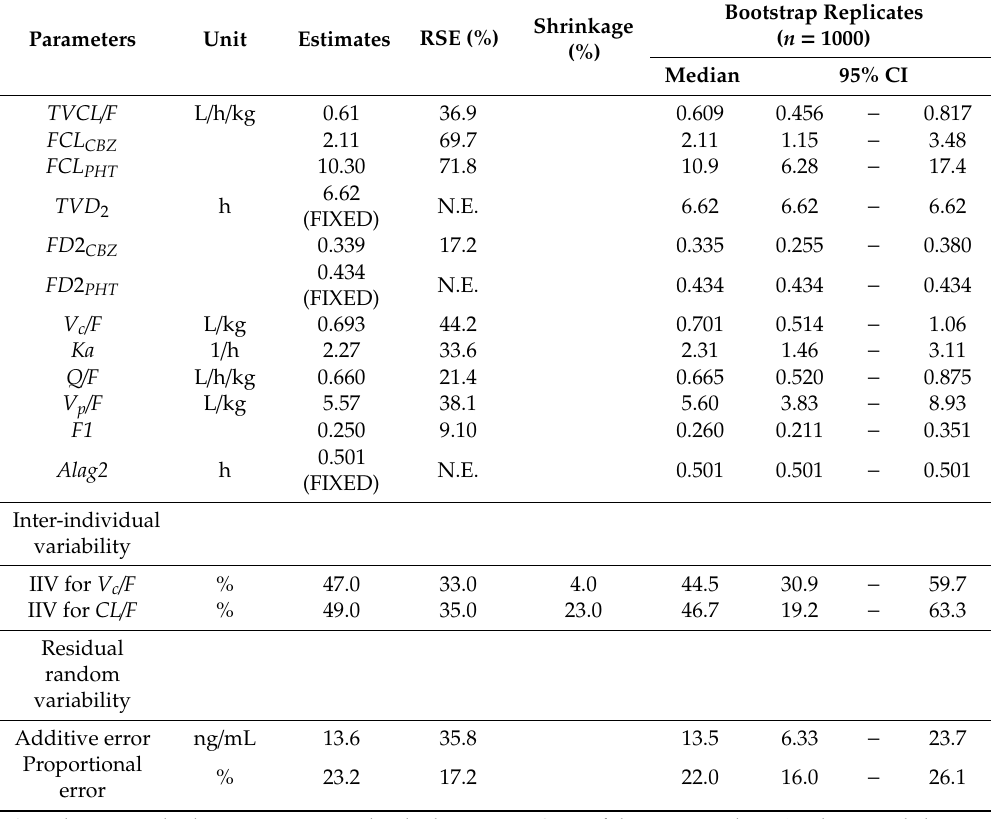
Table 4. Parameter estimates from the final covariate model and results of bootstrap validation for RIV.